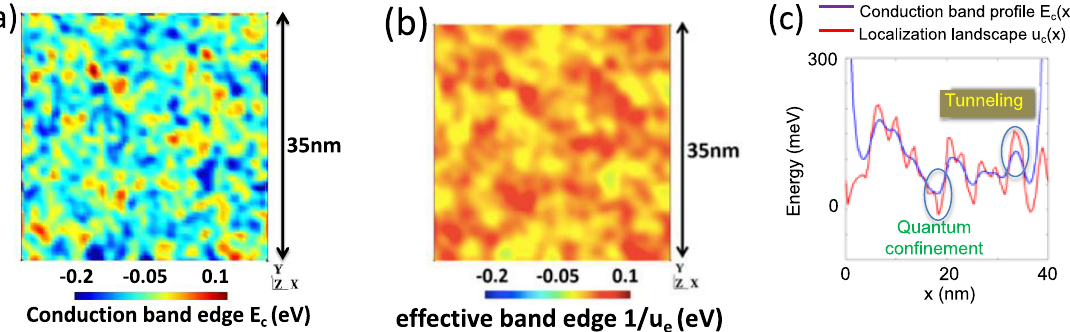
Figure8: (a)Spatialvariationoftheconductionbandminimum E c ( r )forarandomIn 0,14 Ga 0.86 Nalloyand(b)theeffectivepotentialmap1/ u e ( r ) computed through the LL theory; (c) a cut across the x -direction allows comparisons of the fl uctuations of both potentials. One can see that energy fl uctuationsarequitediminishedintheLLtheoryasitcapturestwoessentialingredientsofquantumtheory:quantumcon fi nementand tunneling (from the study by Li et al.